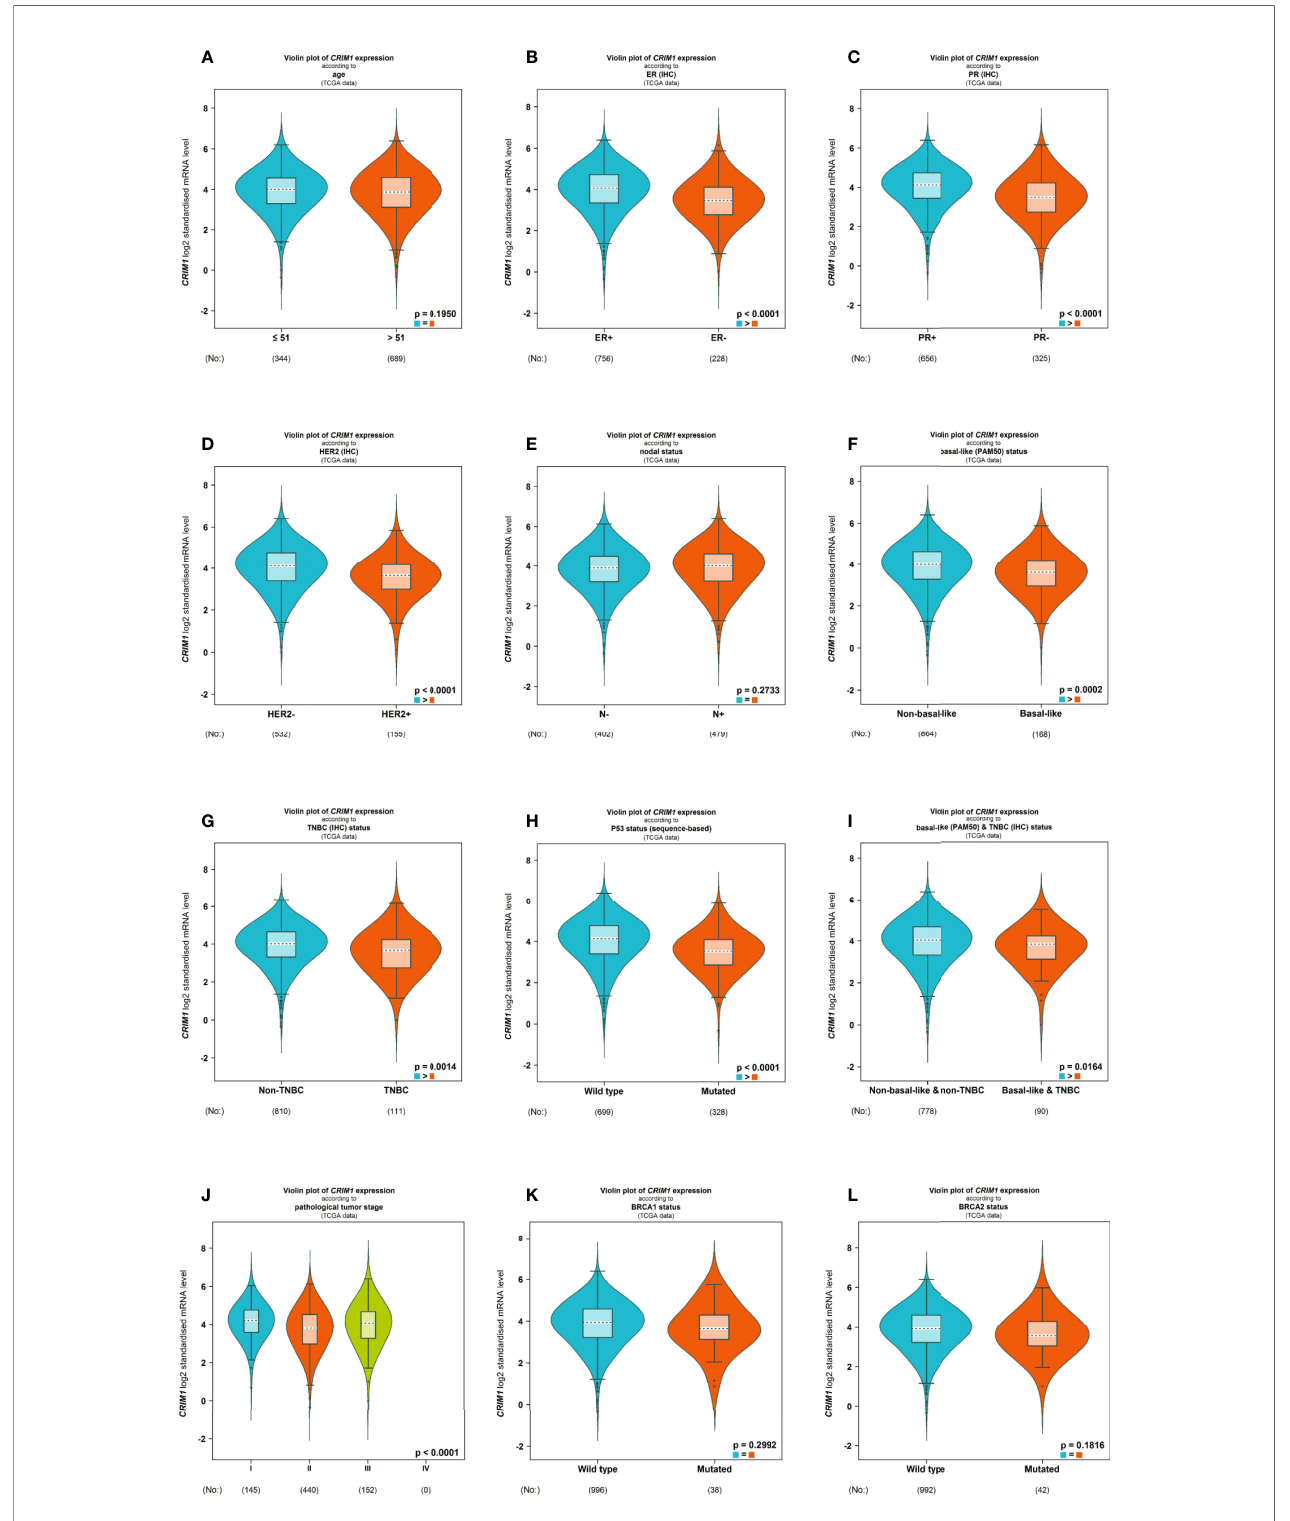
FIGURE 4 | Violin plot illustrated the relationship of CRIM1 expression with clinical indicators using bc-GenExMiner. Data include age (A) , ER (B) , PR (C) , HER-2 (D) , nodal status (E) , basal-like status (F) , TNBC status (G) , P53 status (H) , basal-like & TNBC status (I) , pathological tumor stage (J) , BRCA1 status (K) and BRCA2 status (L)